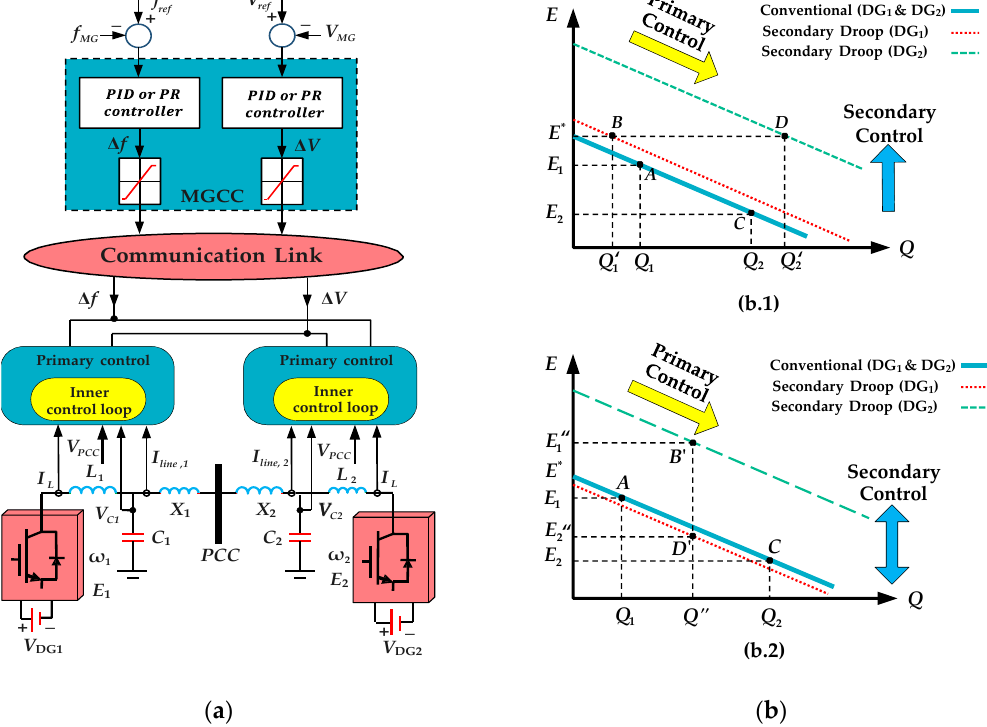
Figure 3. ( a ) The classical control scheme for islanded MG; ( b ) droop control method: one-directional secondary controller effect (b.1) and bi-directional secondary controller effect (b.2) [29,30].